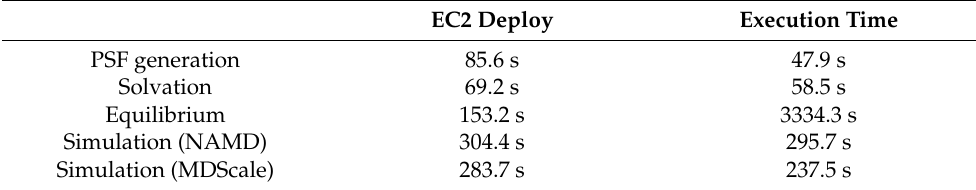
Figure 14. Configuration of the MD simulation in MDScale. Users can specify the details of the simulation and choose the number of GPUs to be used. Table 2. Runtime of each workflow step, differentiating between the deployment time of EC2 instances and the execution time of the MD simulator. MD simulation was performed using 8 GPUs, while the equilibration process was run on only 1 GPU. All other steps do not require the use of